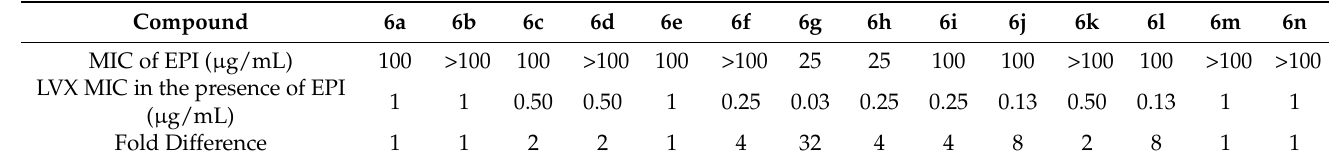
The fused heterocyclic carboxamides were separated into two groups: (1) from